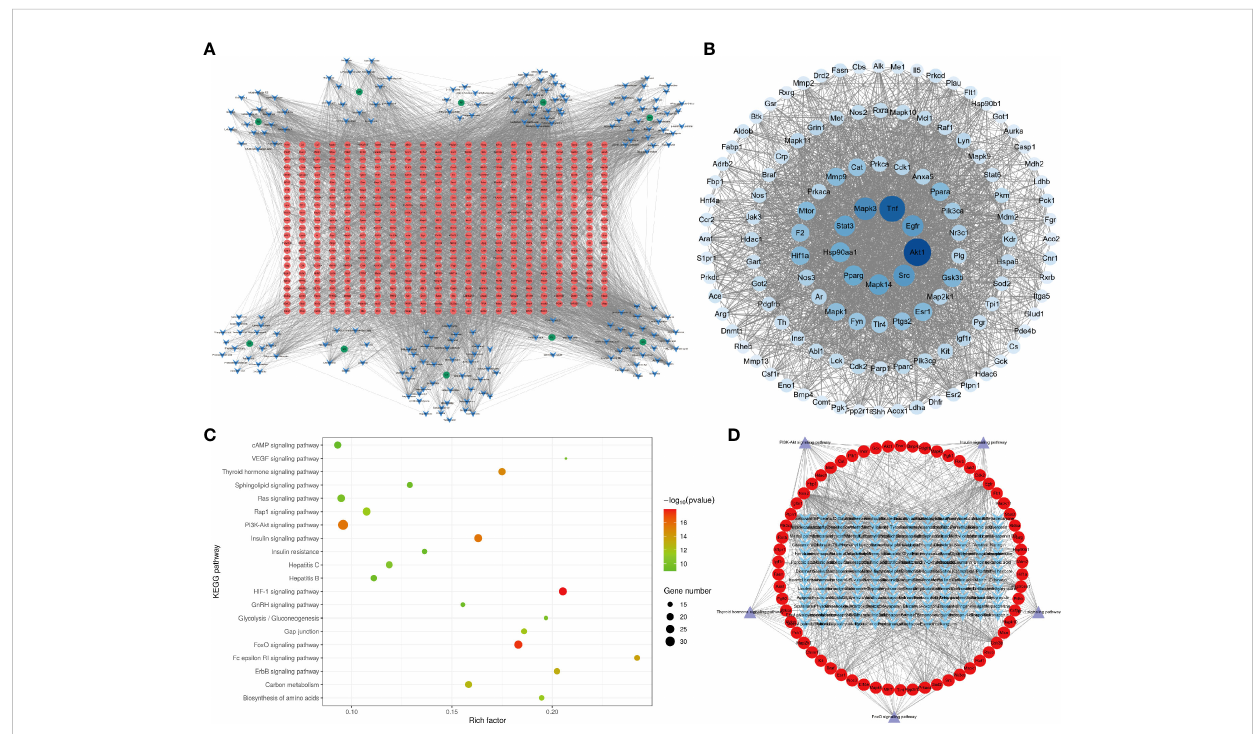
FIGURE 4 Network pharmacology of XHP. (A) The herb – component – target network of XHP in the treatment of ALD. Green represents the herb, blue represents the active components, and red represents the targets. (B) PPI network of XHP in the treatment of ALD. Network nodes represent different proteins. Edges represent protein – protein associations. (C) Kyoto Encyclopedia of Genes and Genomes (KEGG) pathway enrichment analysis of XHP in the treatment of ALD. (D) The component – target – pathway network of XHP in the treatment of ALD. Blue represents the active component, red represents the targets, and purple represents the